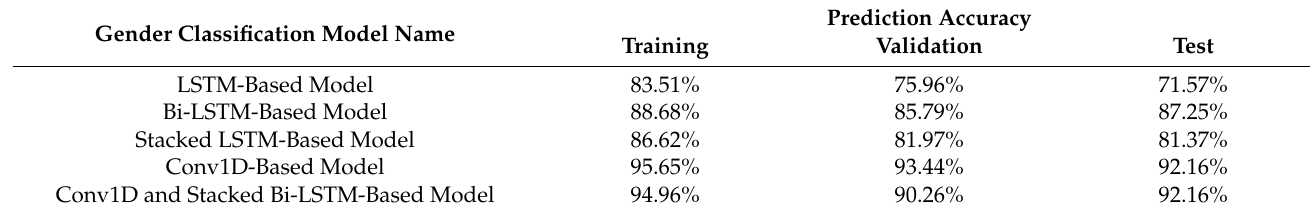
Table 5. Accuracy of five different classifiers for training, validation, and test dataset.